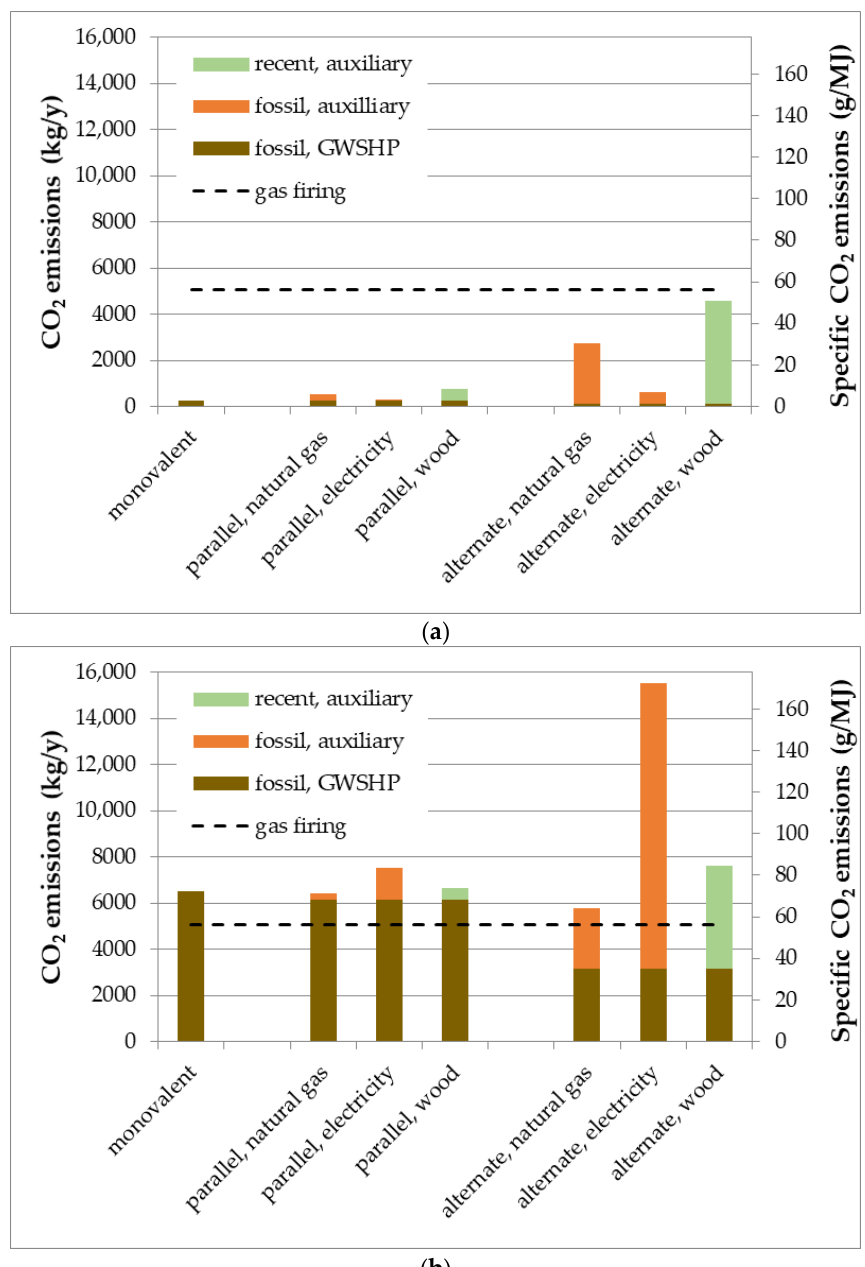
Figure 9. Annual CO 2 emissions of different bivalent GWSHP systems where ( a ) shows “low”, while ( b ) shows “high” CO 2 emissions from electricity